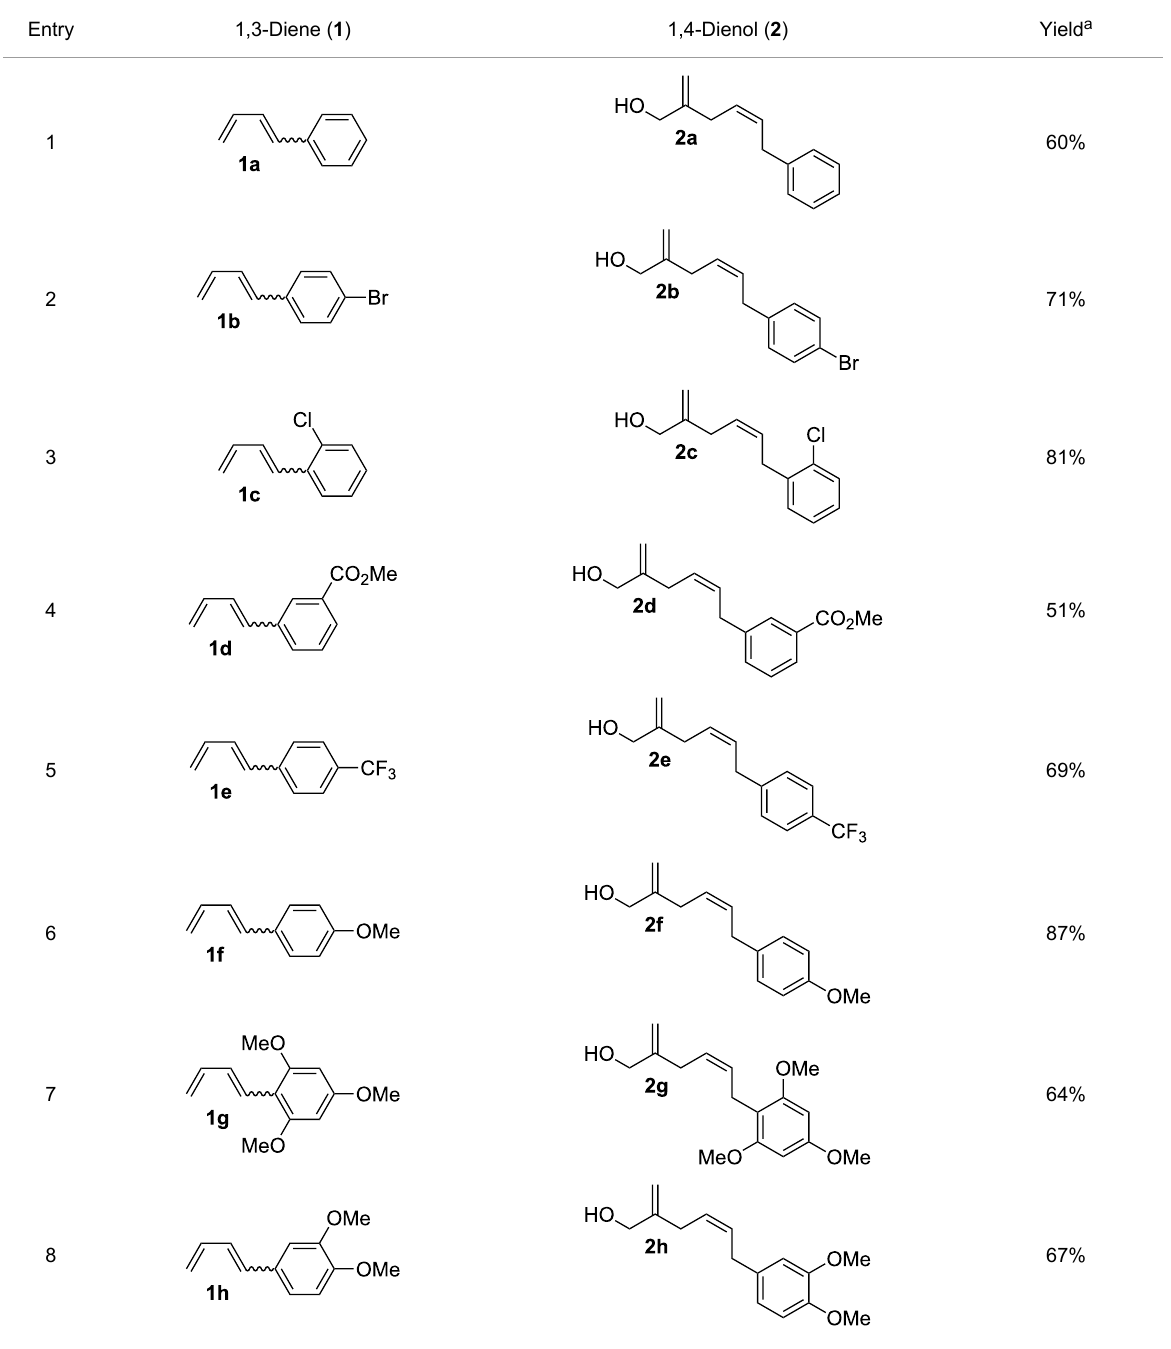
Table 1: Results of the cobalt-catalysed 1,4-hydrovinylation reaction of TMS-protected allylic alcohol with 1,3-dienes of type 1